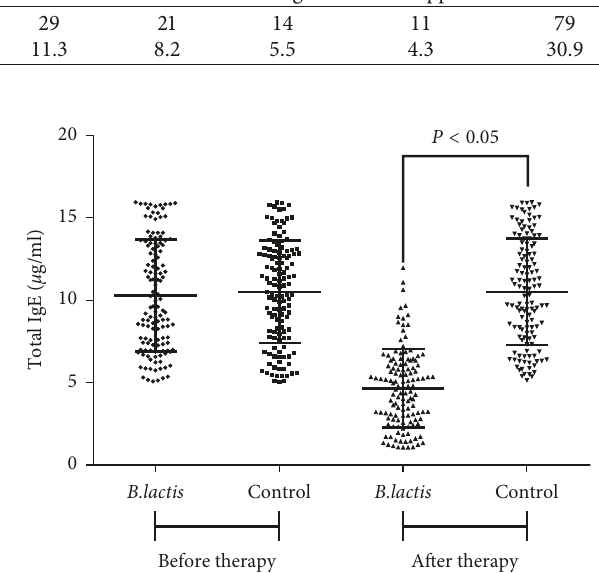
Figure 1: The effects of B. lactis on serum levels of IgE in the children with food allergy. B. lactis group: the patients received B. lactis treatment. Control group: the patients received the solution without B. lactis treatment. n � 128 for each group. The statistical difference was significant if P < 0 .